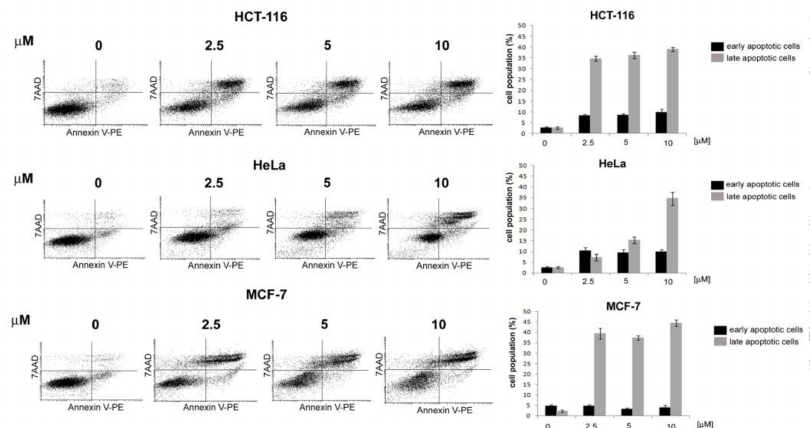
Figure 8. Induction of apoptosis by 28 in HCT-116, HeLa, and MCF-7 cells. Cells were treated with the indicated concentrations of 28 for 48 h (HCT-116) and 72 h (HeLa and MCF-7). Cells were stained with Annexin V-PE and 7-AAD and analyzed with flow cytometry. Dotplots show early apoptotic (bottom right quadrant), late apoptotic (upper right quadrant), viable (lower left quadrant), and necrotic cell populations (upper left quadrant). Values represent mean ± SD of three independent experiments.